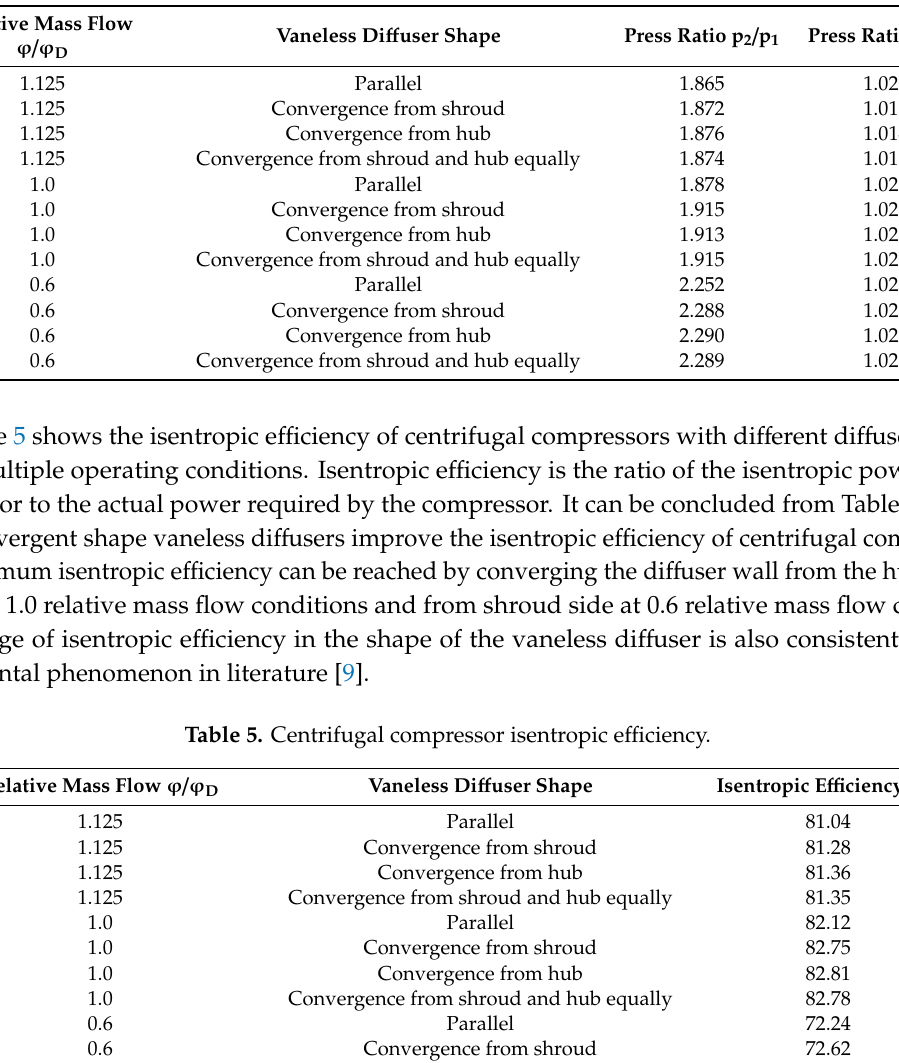
Table 4. Centrifugal compressor impeller and di ff user pressure ratio.